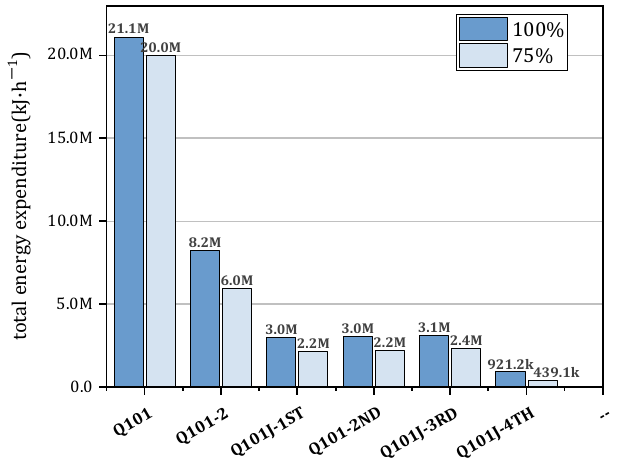
Figure 9. Comparison of unit energy consumption before and after variable working conditions. Combined with analysis of energy consumption units, Q103′s and Q103-2′s relevant PID controllers (TIC-123 and TIC-125, respectively) were optimized to reduce energy consumption levels and shorten fluctuation times. UniSim’s PID controller adopted PI regulation [36,37], where P was the proportionality coefficient, and the value of P directly determined the stability of the controlled curve. The integral term I was introduced to eliminate residual error generated by proportionality regulation and to improve control accuracy. The value of P was important; when the value of P was reasonable, I was fine-tuned. Transition state process ① was selected to analyze the system’s performance after process control parameters were adjusted. First, parameter P of TIC-123 was optimized. Different P values were selected to simulate variable working conditions and to analyze dynamic energy consumption curves, as shown in Figure 10.